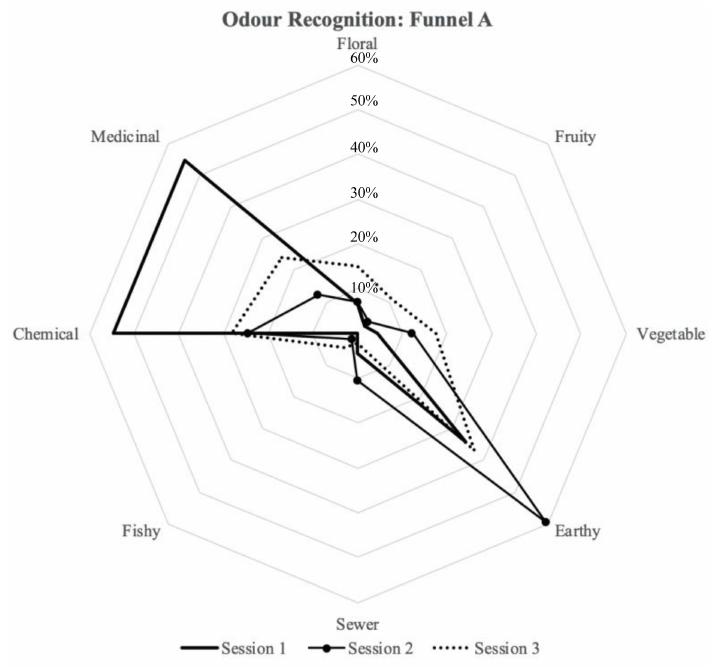
Figure 10. Odor recognition assessment for Chamber